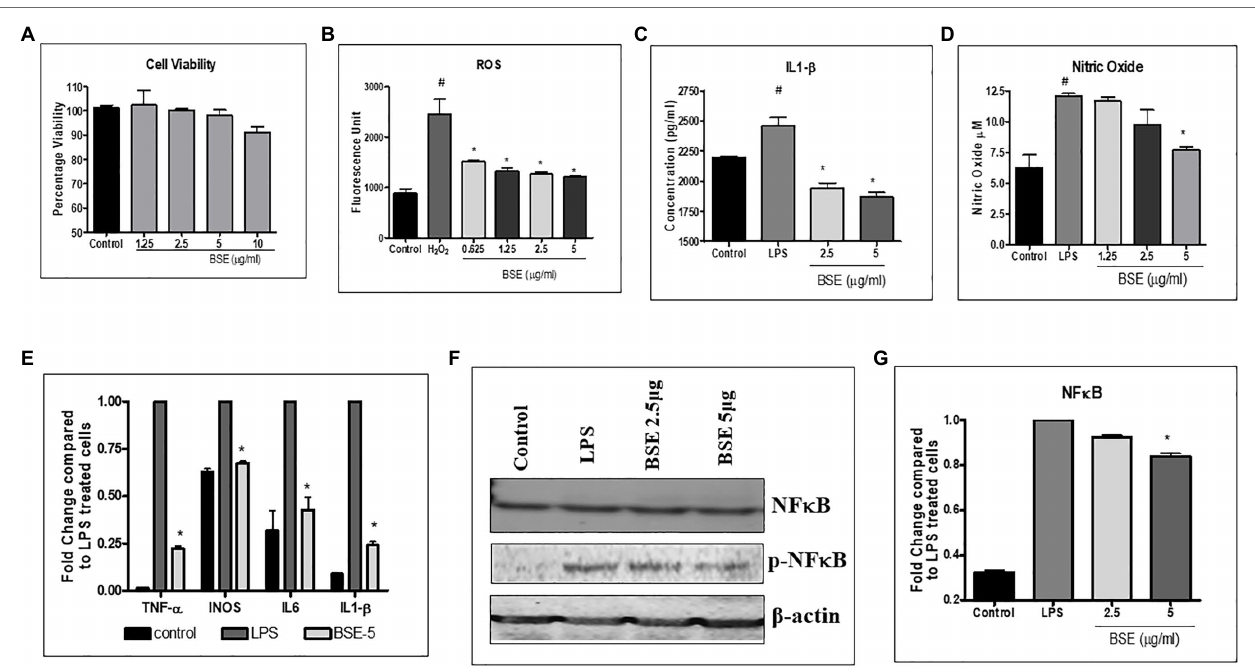
FIGURE 3 | (A) Viability of RAW macrophage cells in the presence of different concentrations of BSE (B) effect of BSE on intracellular reactive oxygen species (ROS) in RAW 264.7 macrophage cells induced with 25 mM hydrogen peroxide (H 2 O 2 ). (C) IL-1 β and (D) nitric oxide (NO) in the supernatant of RAW 264.7 macrophage cells induced with LPS (500 ng/ml). (E) Effect of BSE on relative gene expression of inflammatory biomarkers iNOS, TNF- α , IL-6, and IL-1 β in LPS (50 ng/ml) induced RAW 264.7 macrophage cells. (F) and (G) effect of BSE on relative protein expression of inflammatory biomarker p-NF κ B in LPS (50 ng/ml) induced RAW 264.7 macrophage cells. # p < 0.05 compared to control; * p < 0.05 compared to negative control H 2 O 2 for ROS and LPS for IL-1 β and